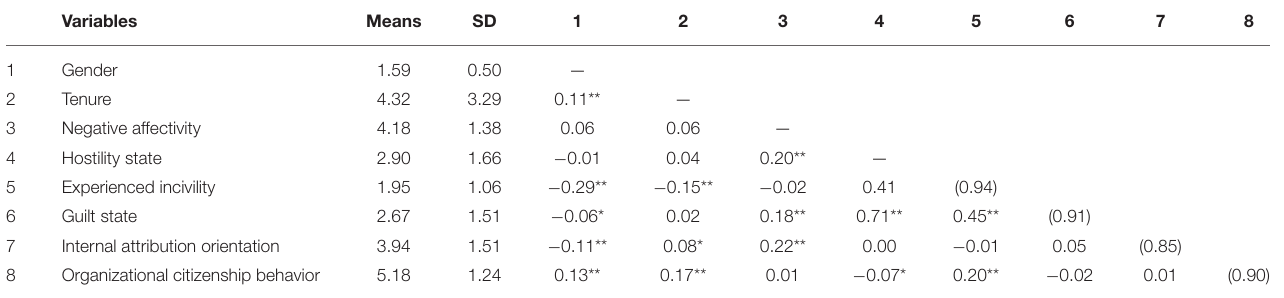
TABLE 1 | Means, SDs, reliabilities, and correlations among study